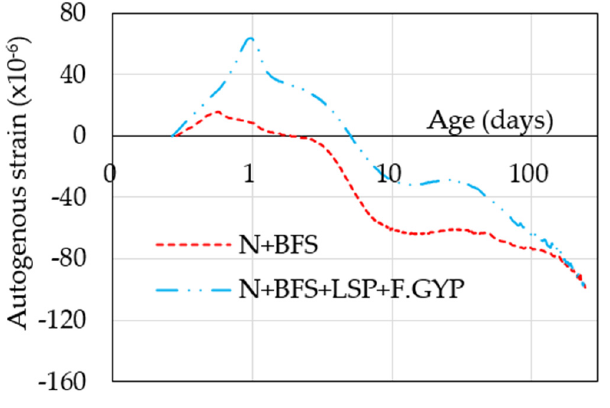
Figure 7. Autogenous shrinkage.